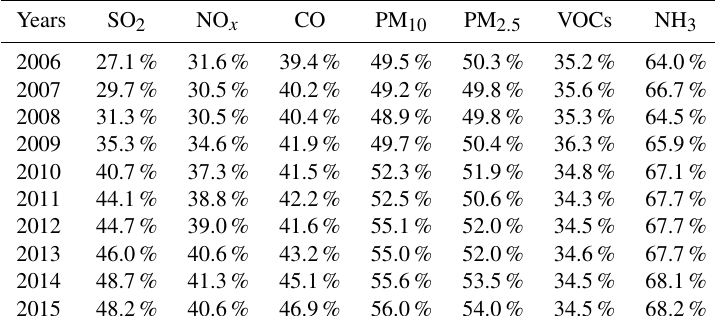
Table 1. Proportions of emissions in NPRD to the total emissions in GD.